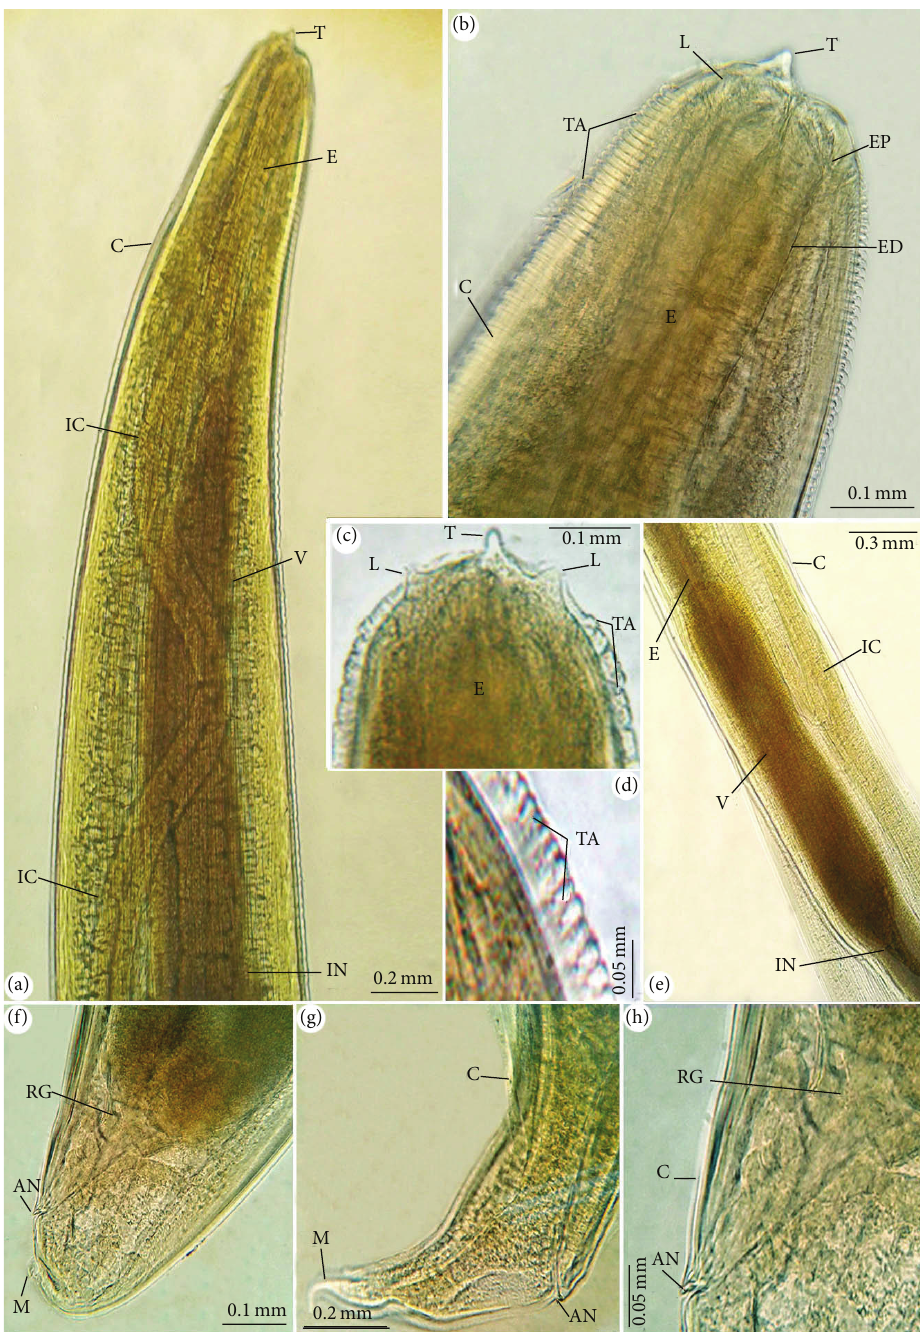
Figure 1: Photomicrographs for different body parts of Anisakis simplex (L3). (a)–(c) The anterior end with the boring tooth (T), labia papillae (L),esophagus(E),ventriculus(V),intestine(IN),intestinalcaeca(IC),excretorypore(EP),andexcretoryduct(ED)withhighmagnifications in (b), (c). (d) The cuticle (C) showing its transverse annulations (TA). (e) Ventriculus (V) with oblique junction with intestine (IN). (f)–(h) Posterior end with anus (AN), rectal gland (RG), and mucron (M) with high magnification in